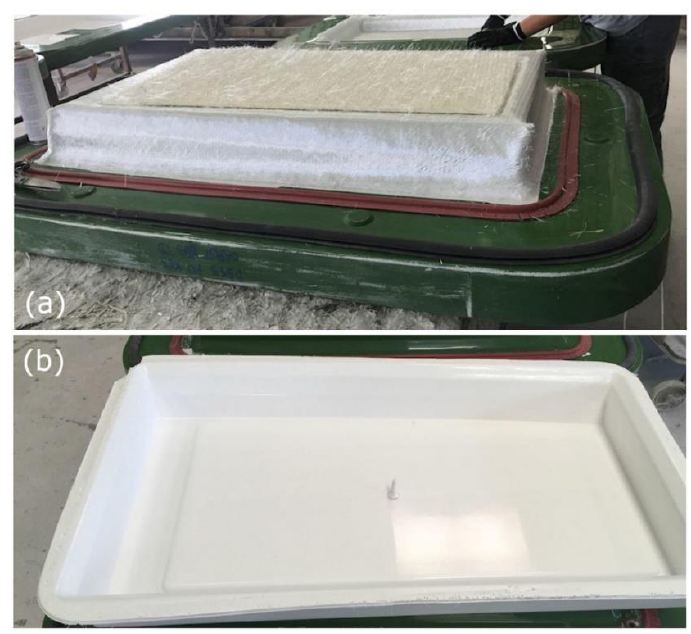
Figure 7. Fiberglass component manufacturing: ( a ) Dry material before resin infusion, ( b ) finished part.